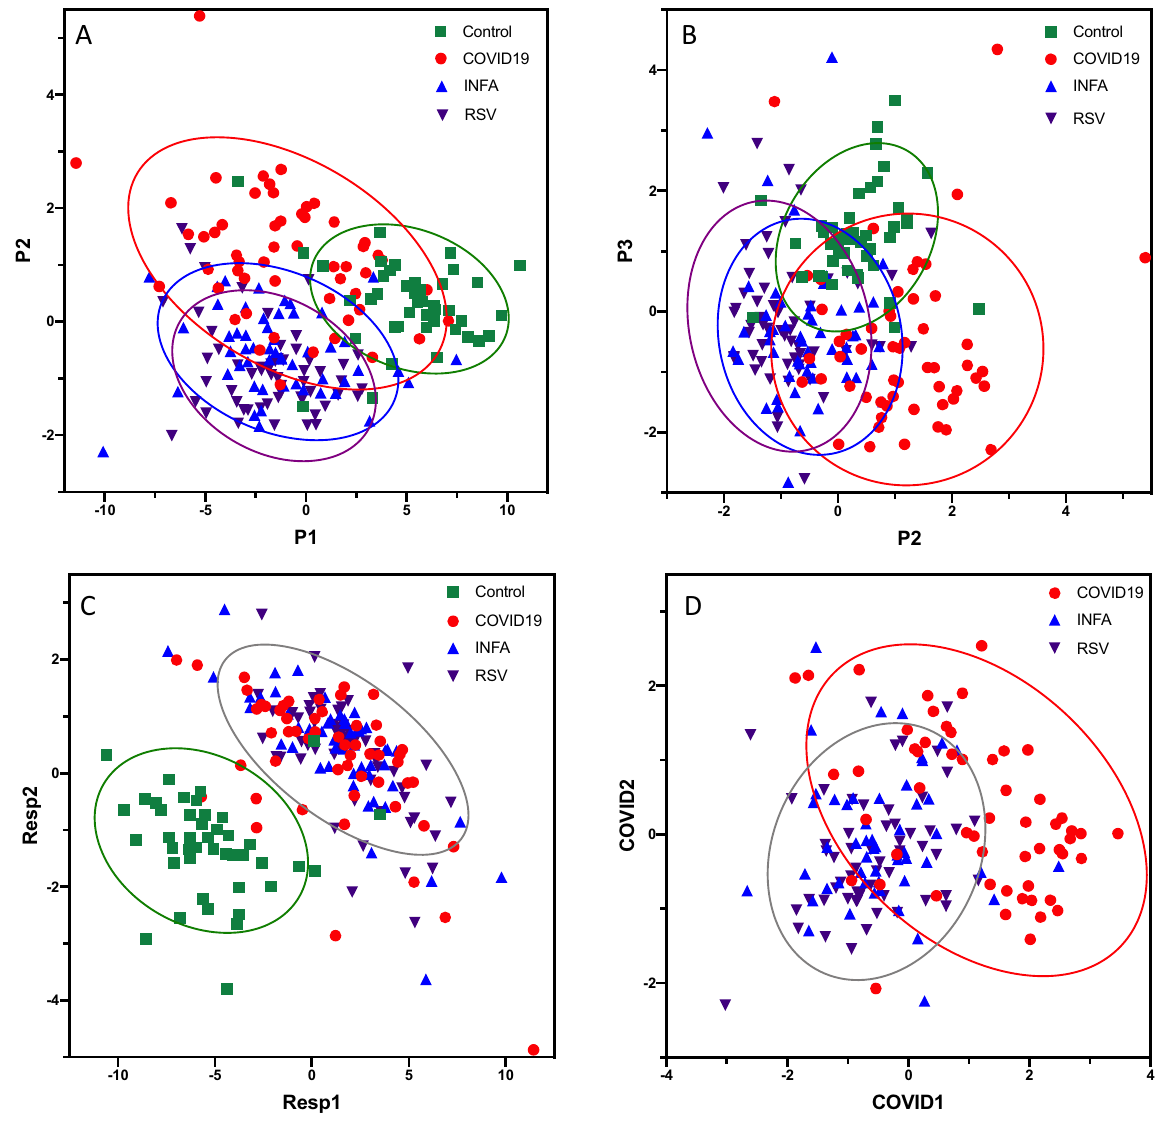
Figure 2. Multivariate analysis and classification of patients with respiratory illness based on metabolite profiles. Supervised partial least squares discriminant analysis was used to plot analyte profiles in VTM from clinical nasopharyngeal swabs scaled to control VTM. Plots of components 1 and 2 ( A ) and 1 and 3 ( B ) are shown where optimal separation of patient groups was observed. Orthogonal partial least squares discriminant analysis was used to plot analyte profiles among patient groups. In ( C ), all patients with a respiratory illness were grouped into a single category and compared to unaffected controls. In ( D ), COVID19 patients were compared to all other patients with influenza A and RSV were tr into a single category. The 95% confidence region is circled for each